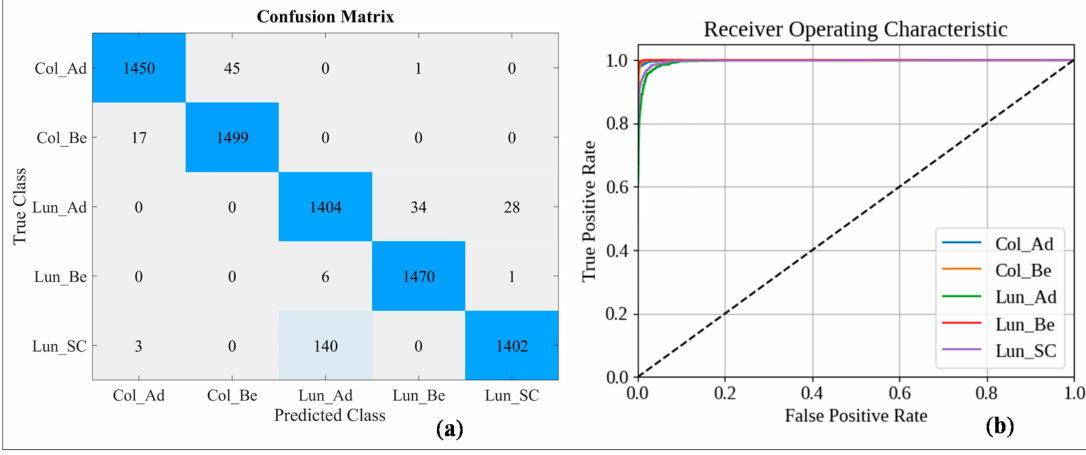
Figure 10. Classification outcome showing the ( a ) confusion matrix and ( b ) ROC curve of the 488th